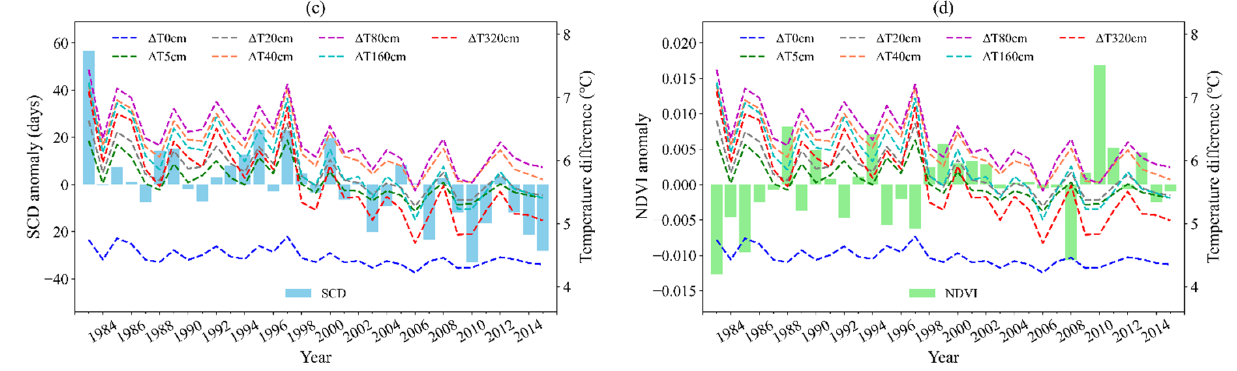
Figure 4. The series of SCD anomaly ( a , c ), NDVI anomaly ( b , d ), soil temperature anomaly and the temperature difference between the atmosphere and the soil.